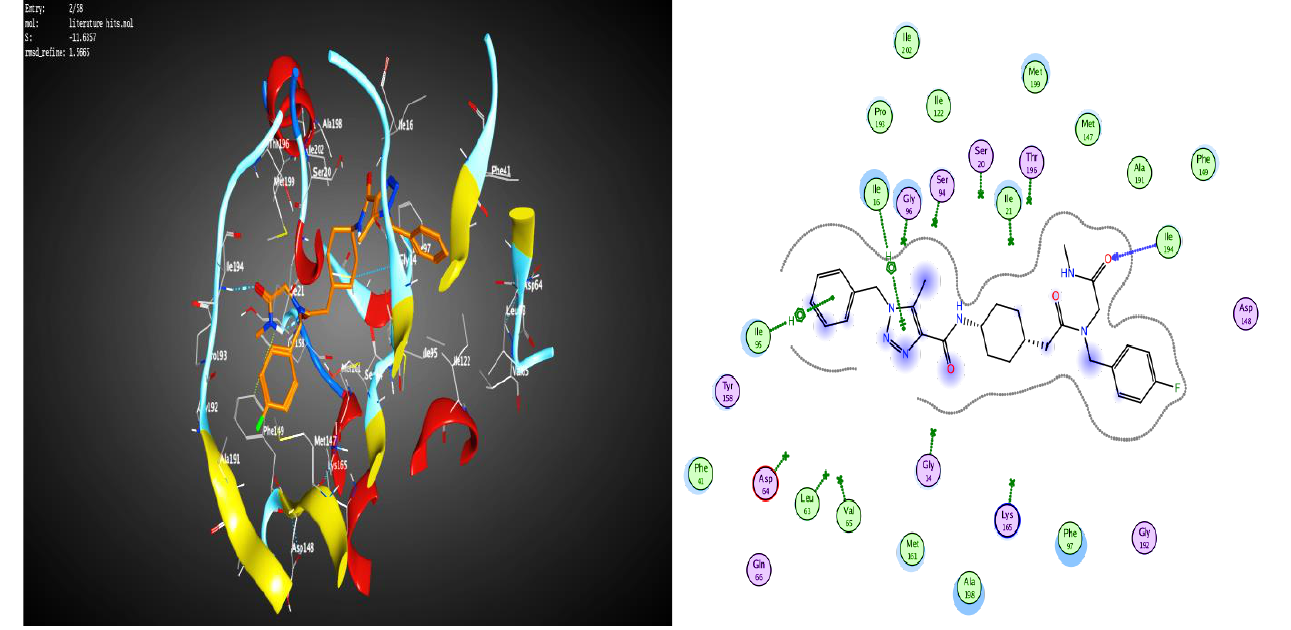
Figure 10. Docking and binding pattern of Lead structure B (brown) into inhA active site in 2D (right panel) and 3D (left panel). panel ) and 3D ( left panel ).